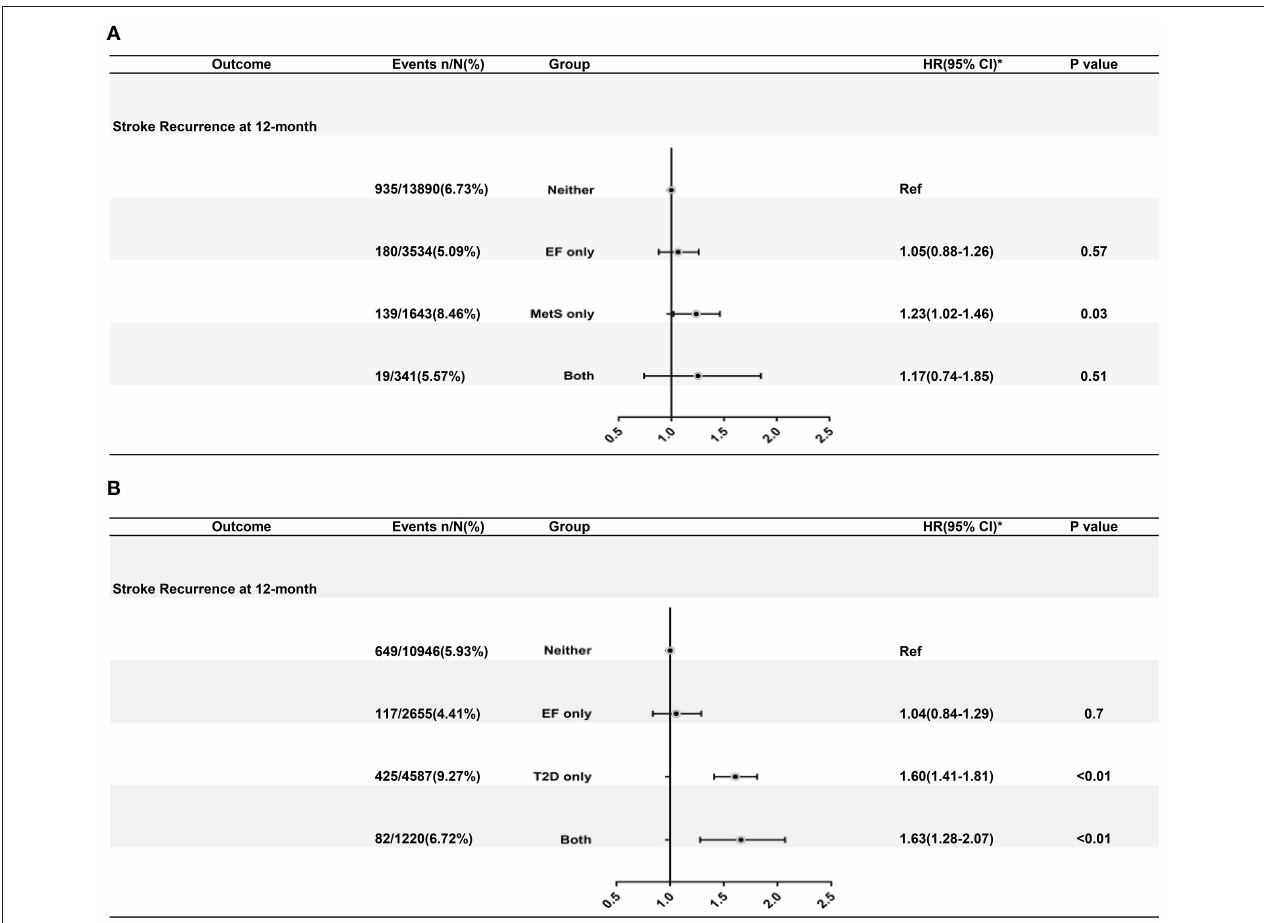
FIGURE 3 | (A) Adjusted hazard ratios of 12-month stroke recurrence according to CDS defined MetS and famine exposure status. (B) Adjusted hazard ratios of 12-month death from any cause according to T2D and famine exposure status. Estimation of hazard ratios was after adjusting for age, sex, history of ischemic stroke, myocardial infarction, atrial fibrillation, hypertension, diabetes mellitus, dyslipidemia, National Institutes of Health Stroke Scale at admission, and modified Rankin Scale before index stroke. HR indicates hazard ratio, CI indicates confidential interval, EF indicates exposure to famine, MetS indicates metabolic syndrome, T2D indicates type 2 diabetes